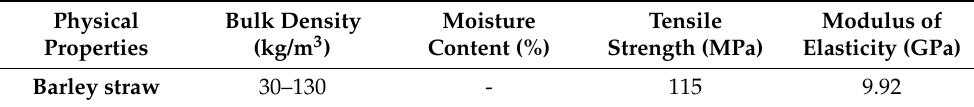
Table 13. Natural fiber properties of barley straw